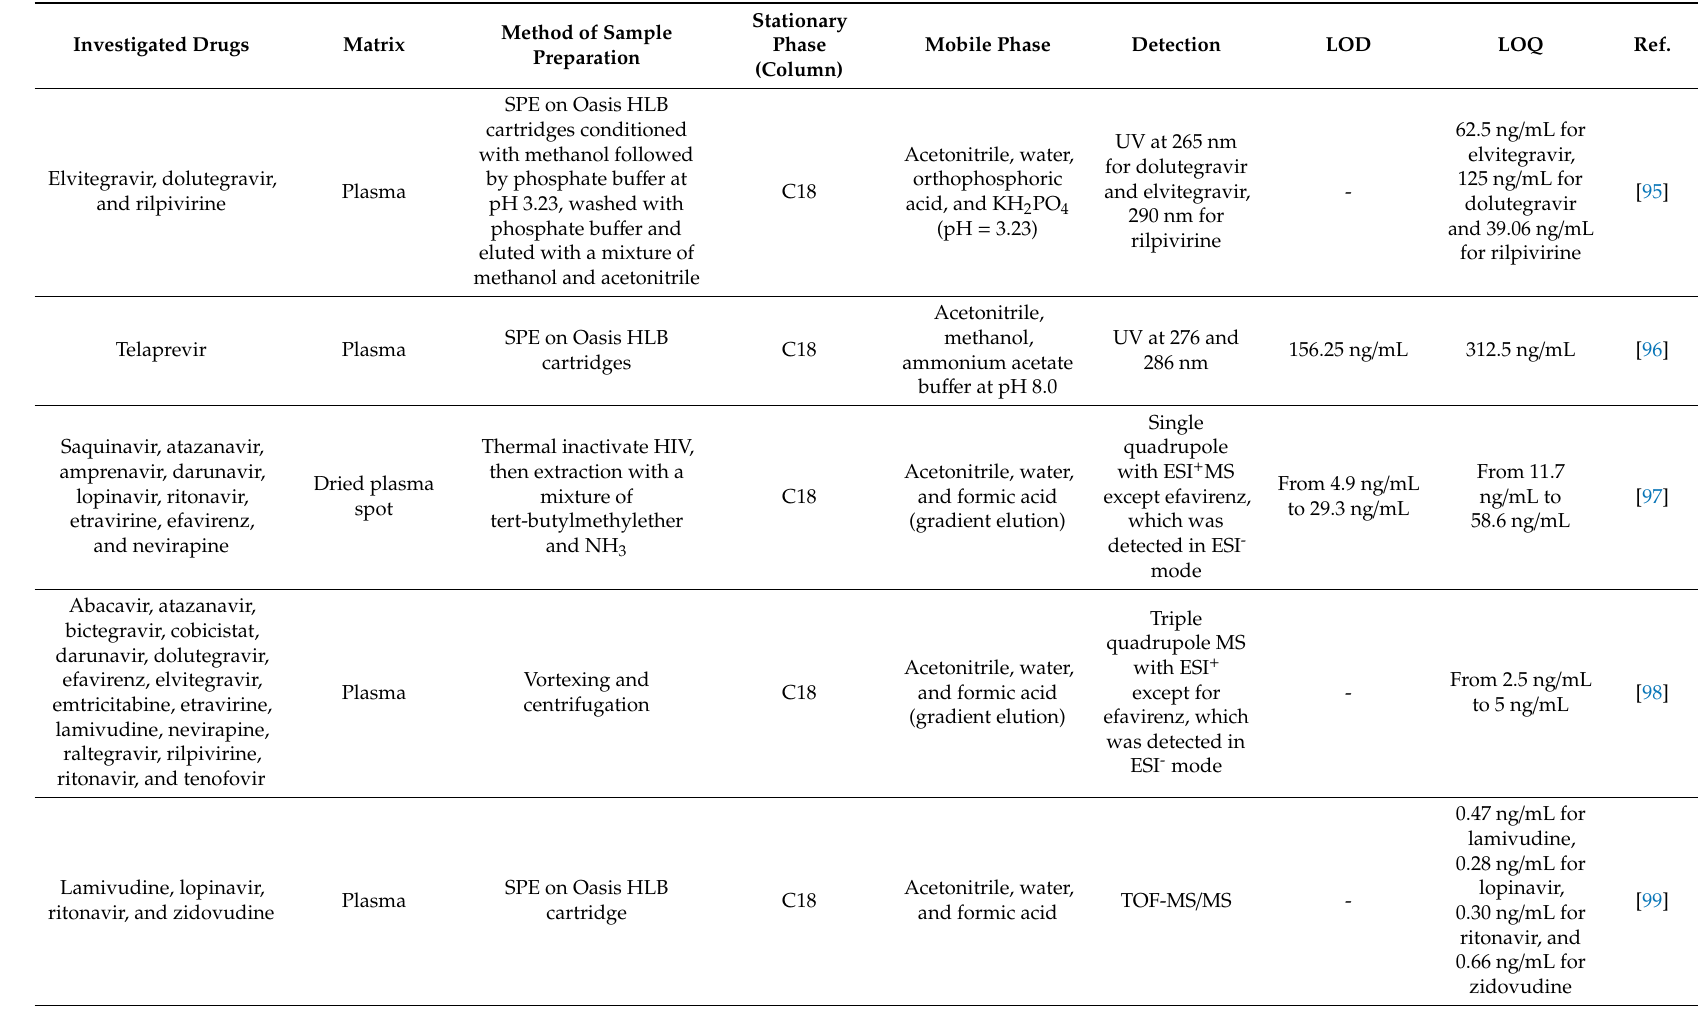
Table 5. Antiviral